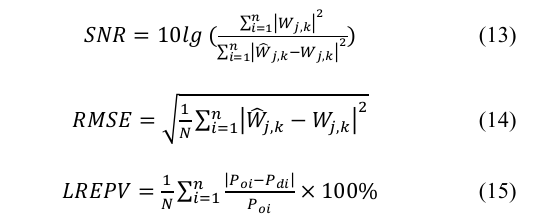
Table 1: The waveform is smooth after denoising by the soft